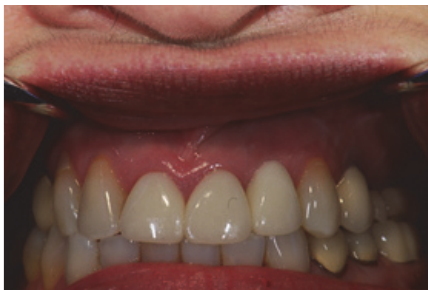
Figure 10: Provisional crown on the implant.